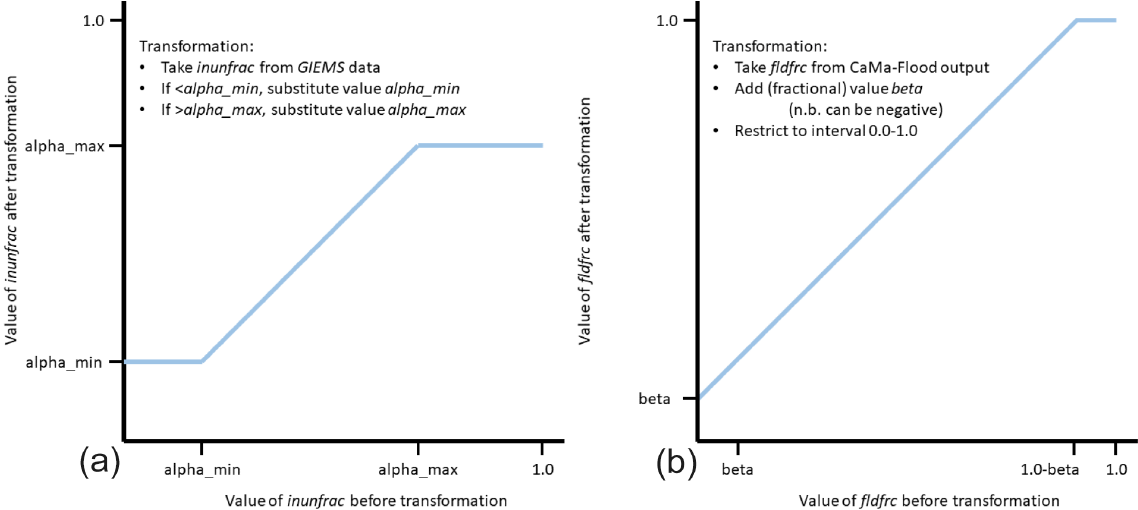
Figure 2. Transforming the GIEMS inundated fraction (inunfrac) data (a) and CaMa-Flood output flooded fraction (fldfrc) variable (b) . Note that values α min = β = 0 . 0 and α max = 1 . 0 are equivalent to making no